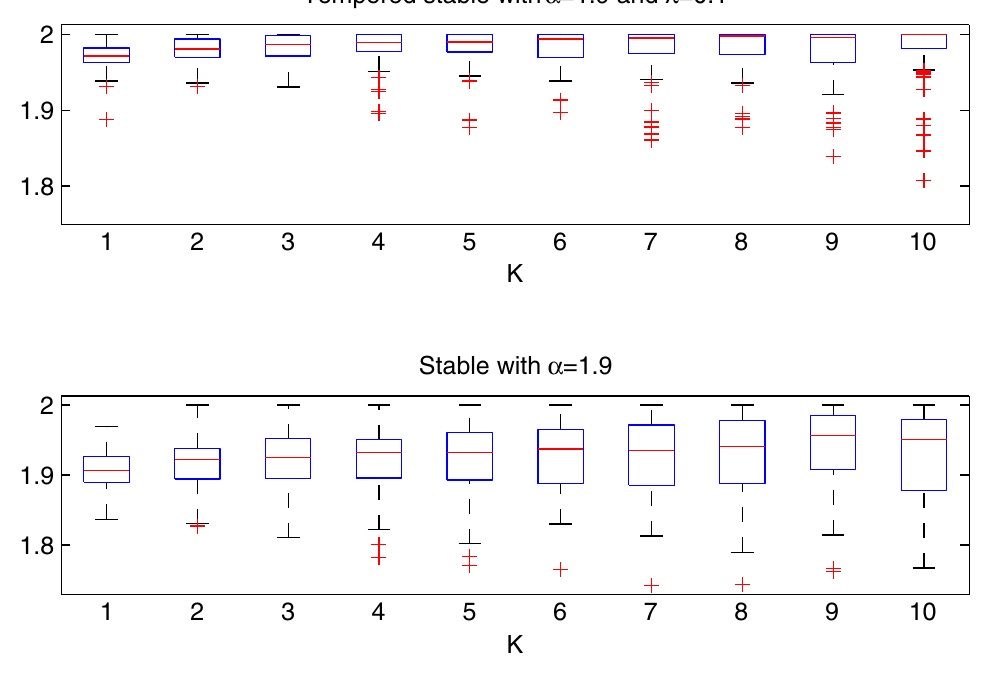
Fig 4. Estimated α values for the symmetric tempered stable sample from the top left panel of Fig 3 (top panel) and for the symmetric stable sample from the top right panel of Fig 3 (bottom panel). The box plots were constructed from 100 bootstrap samples of length